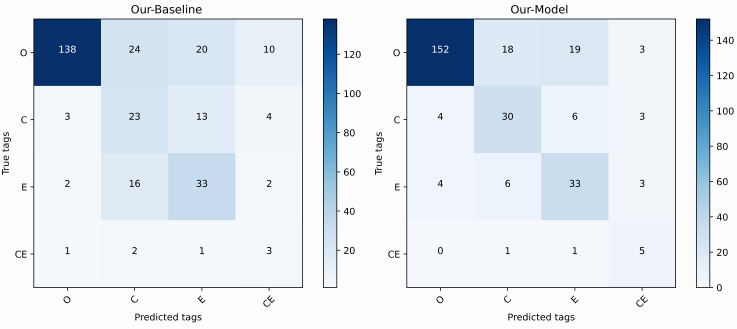
Figure 17. Contrasting models in testing multi-causal label